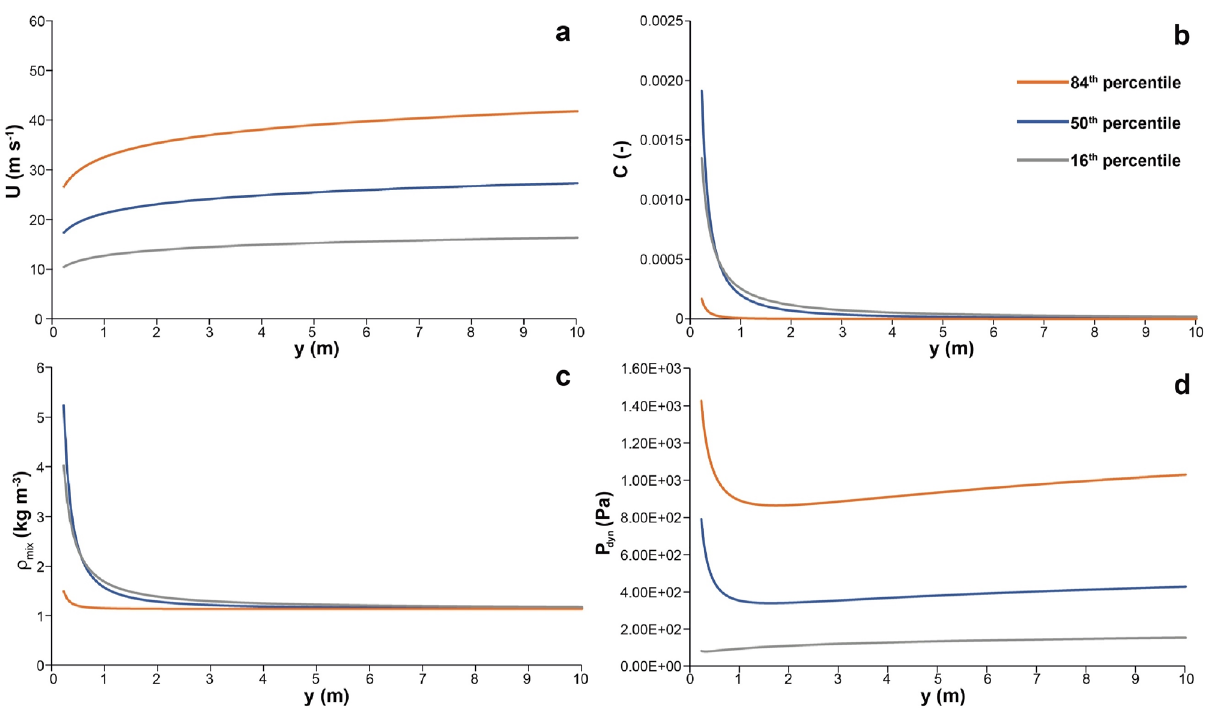
Figure 2. Profiles of the impact parameters representing the flow dynamic pressure. The curves refer to the minimum (16th percentile), the average (50th percentile) and the maximum (84th percentile) of